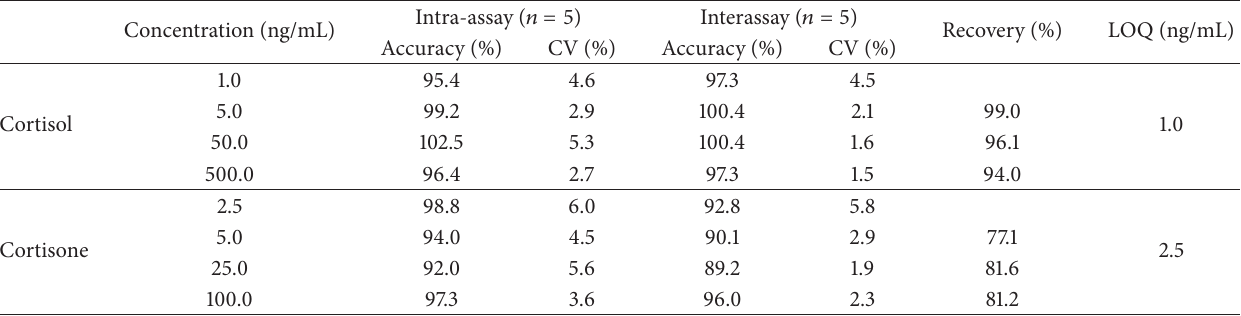
Table 1: Method validation results of the LC-MS/MS assay.